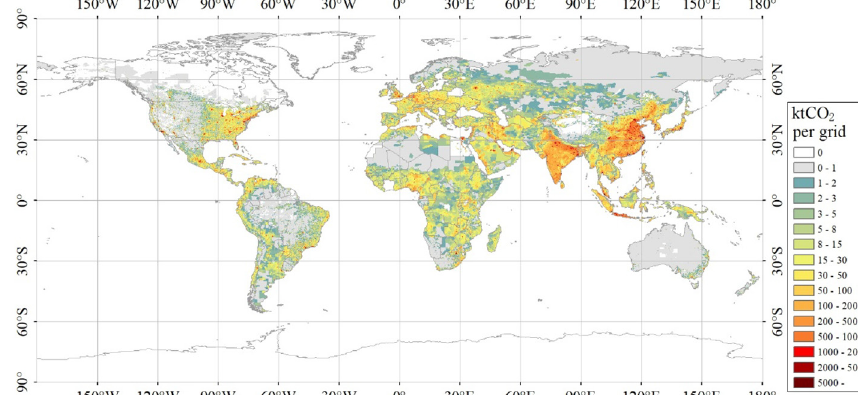
5,000 ktCO . These areas are mainly populated areas with high population concentrations 2 because of the highly developed urban economy. The detailed carbon emission pattern can be seen through local area ampli fi cation, which is highly consistent with the allocation of the urban system (Figure 7). For example, China ’ s eastern coastal city clusters, the megacities of India and the city clusters of the eastern plains of the USA are all well-re fl ected in the allocation pattern of carbon emissions. The Eurasian land bridge connected by the cities can also be seen on the map. The carbon emission pattern based on urbanization and population allocation can clearly re fl ect the allocation of global urban carbon sources. Studies have pointed out that urbanization is actually another environmental problem in this century because rapid urbanization means changes in lifestyle, as well as increased consumption and energy use (Hoornweg et al. , 2010; Li et al. , 2015b; Wang et al. , 2016). This, in turn,